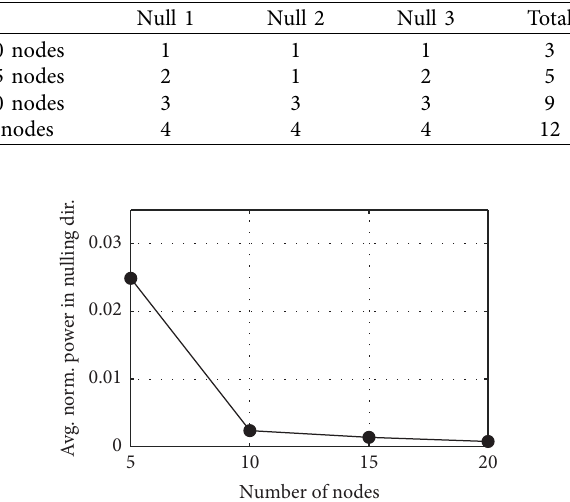
Table 11: Nulling accuracy (in degrees) corresponding to null steering using 20, 15, 10, and 5 nodes.